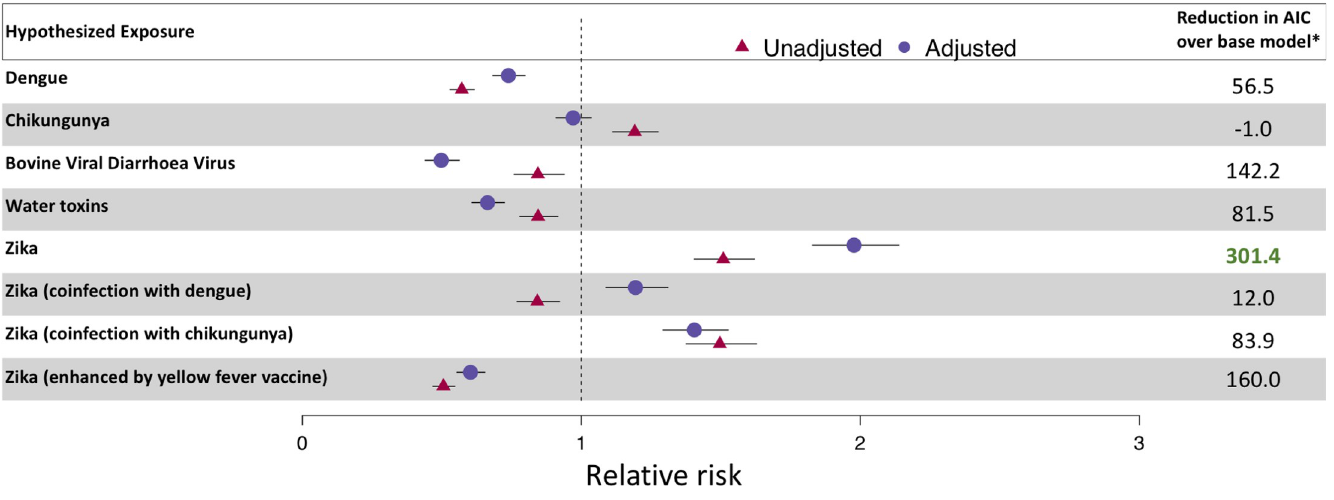
Fig 2. Association between candidate exposures and microcephaly with structural brain defects. Relative risk compares areas with no exposure to those with median incidence of the exposure. Adjusted models included variables for region and sex of the baby (only bovine viral diarrhoea virus, Zika, and Zika [chikungunya coinfection] models; S2 Text, section 2.9). � The final column shows the Akaike Information Criterion (AIC) of a base model including a covariate for region minus the AIC of the adjusted exposure model (a larger reduction in AIC value equates to a more likely exposure model).